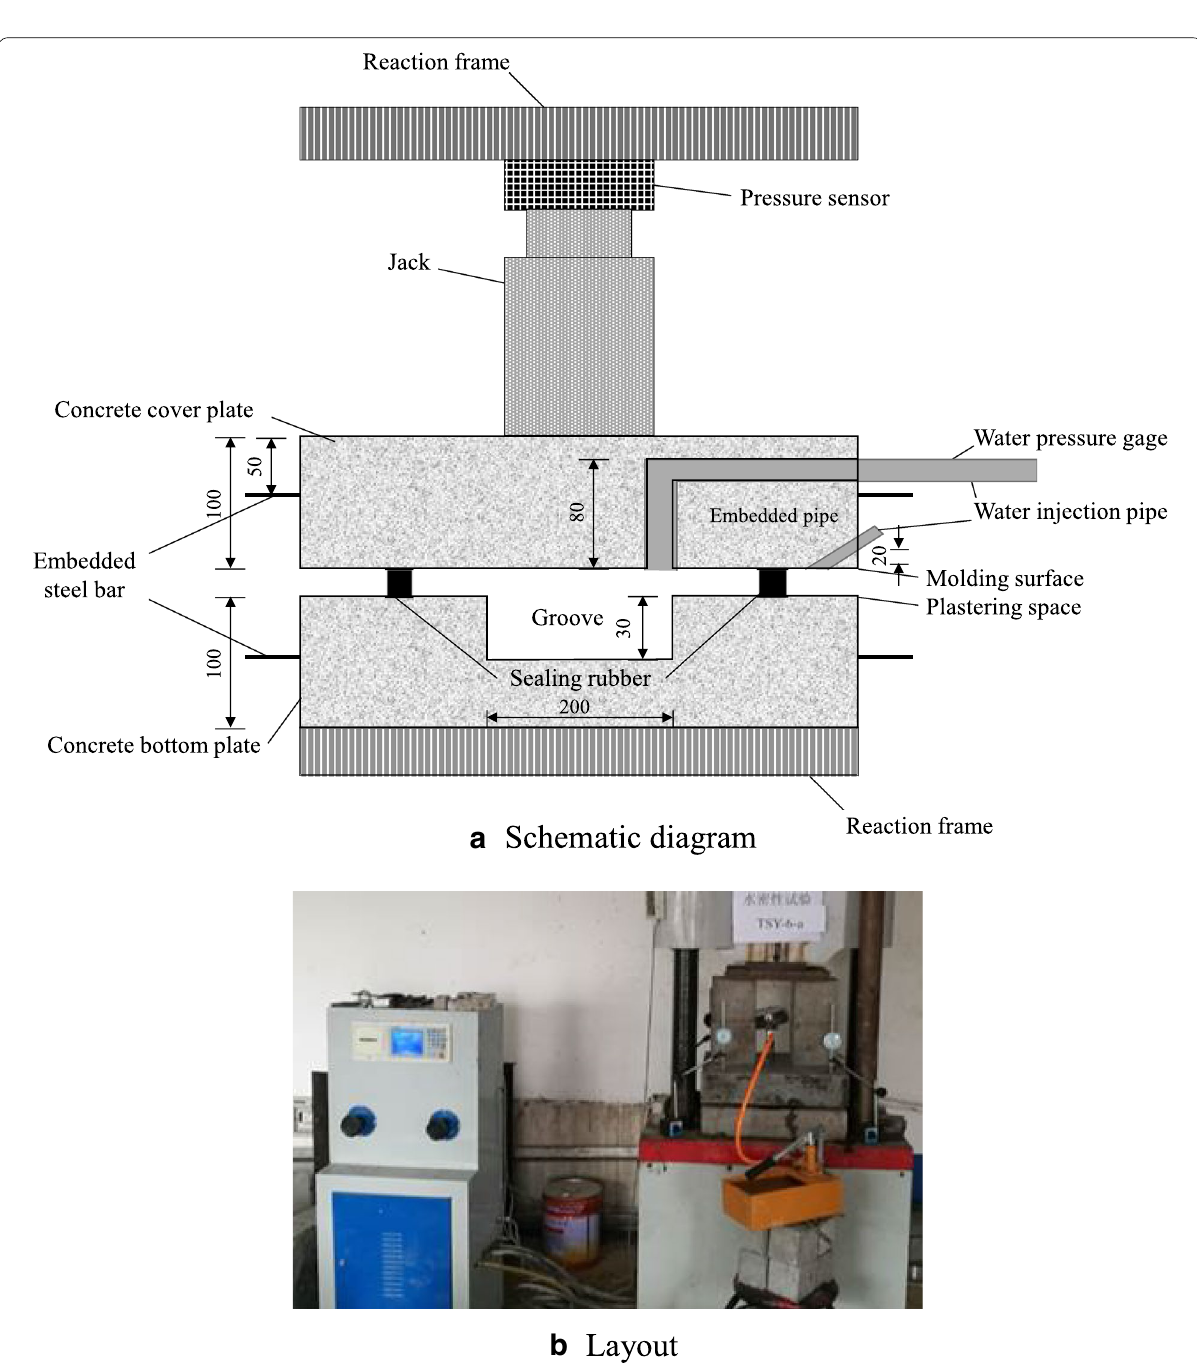
Fig. 4 Waterproofing experimental device: a schematic diagram; and b layout (units are in